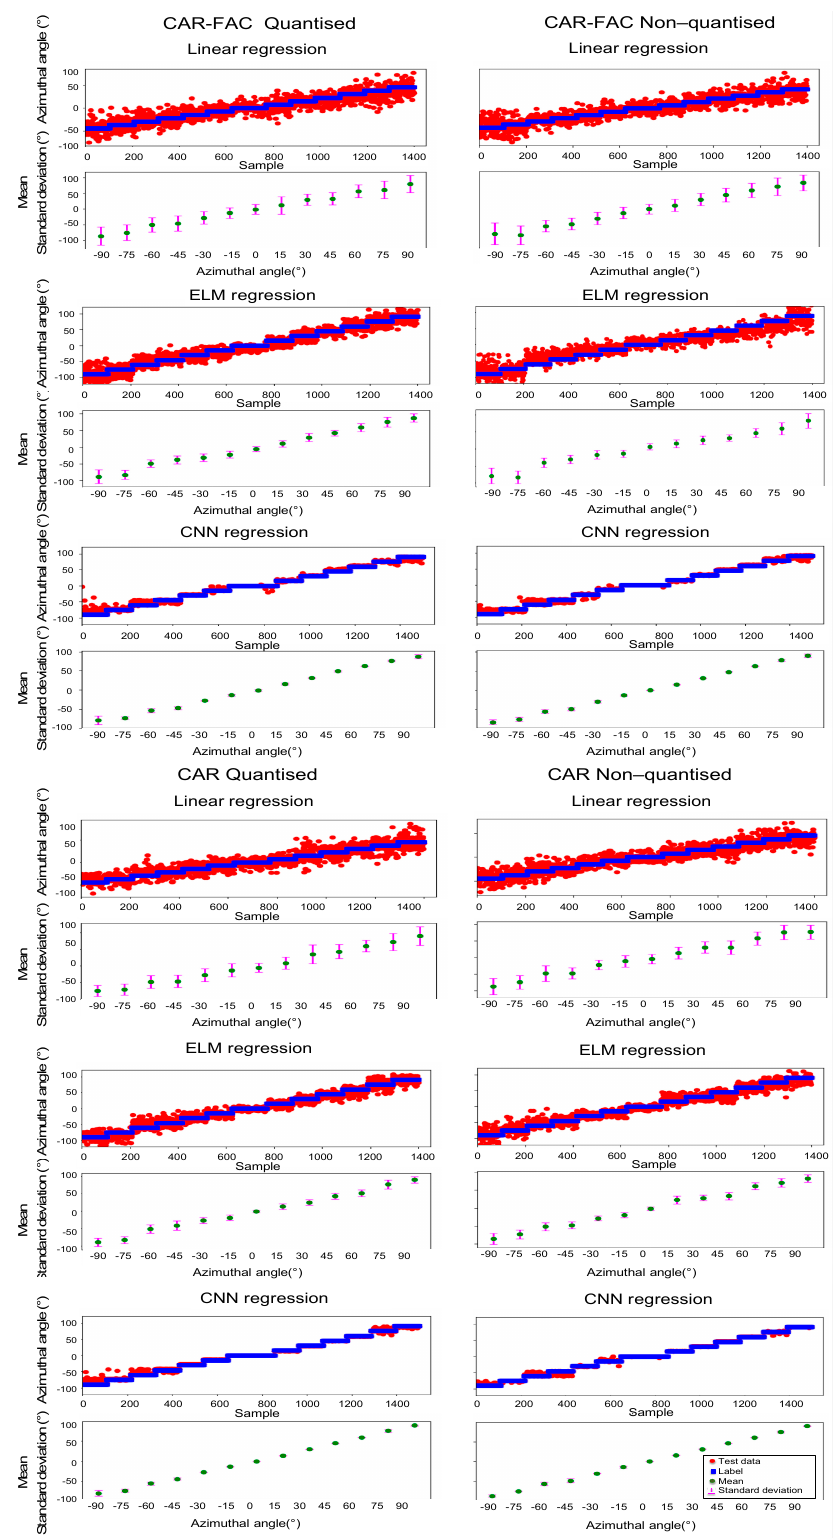
Figure 9. Comparisons of the linear regression ( top ), ELM regression ( middle ), and CNN regression ( bottom ) on the experimental data. The true location is shown in blue square, and the testing data result is shown in red round.